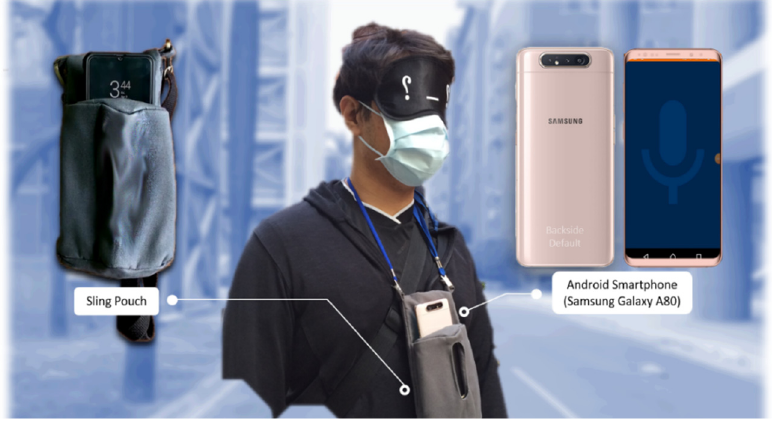
Figure 2. Proposed wearable mobility assistive system by using Android smartphone ( right ) and sling pouch ( left ).